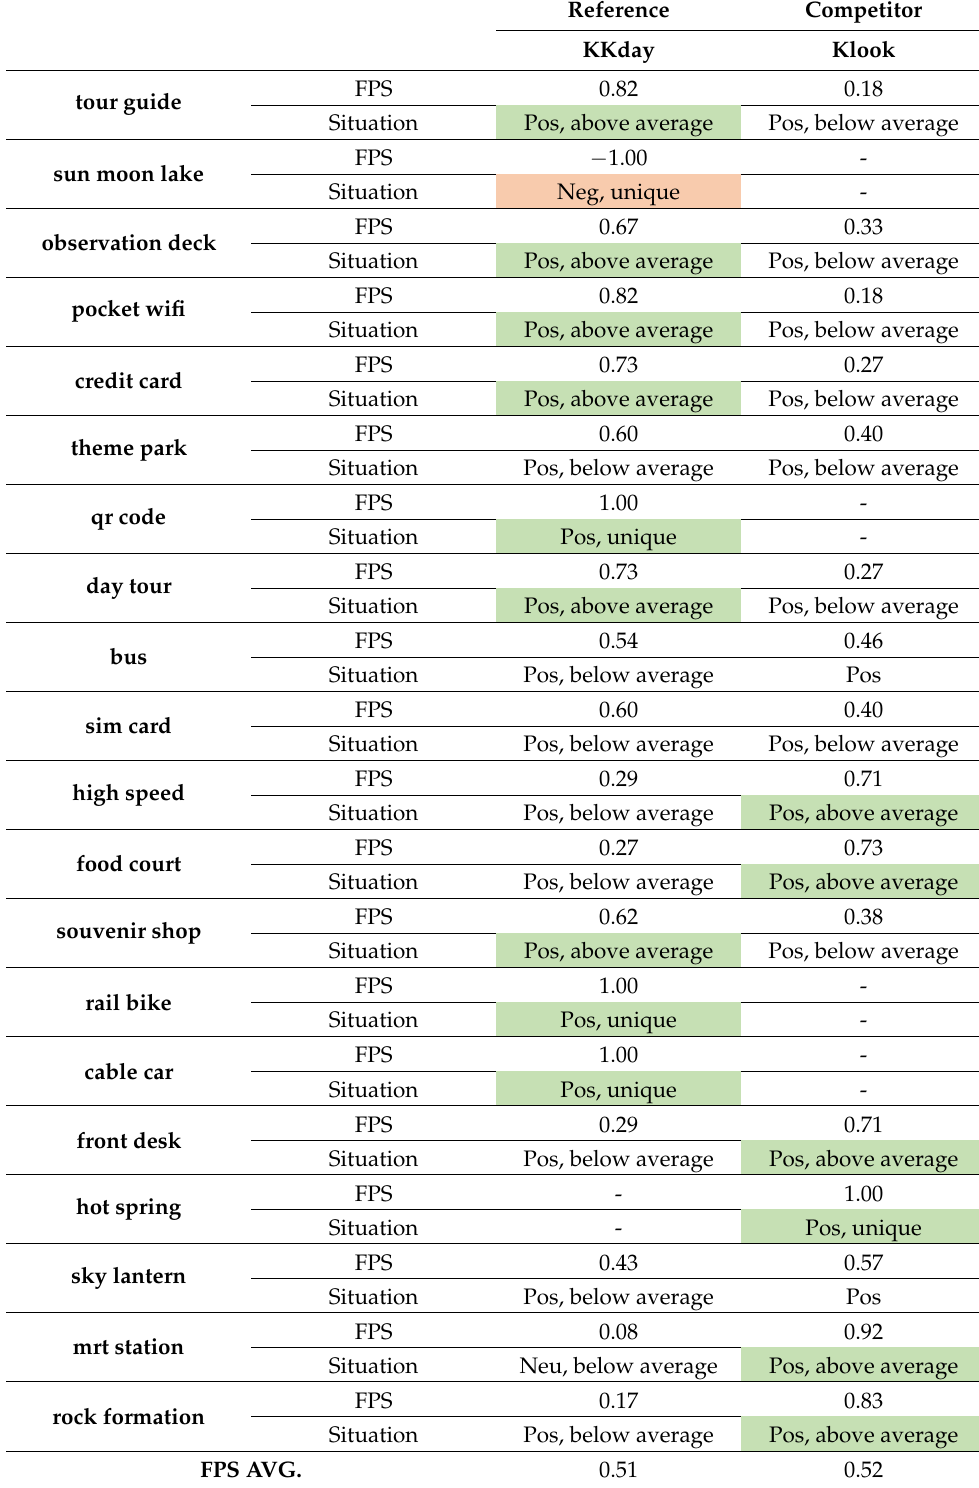
Table 2. FPS and category of each feature ( σ =